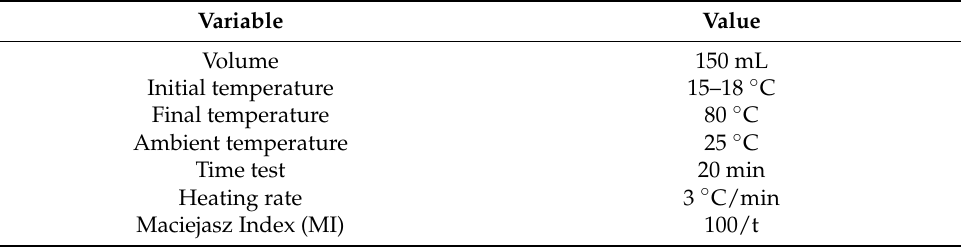
Figure 4. Experiment for determining the MI. Table 2. Thermogravimetry Maciejasz Index (MI) variables